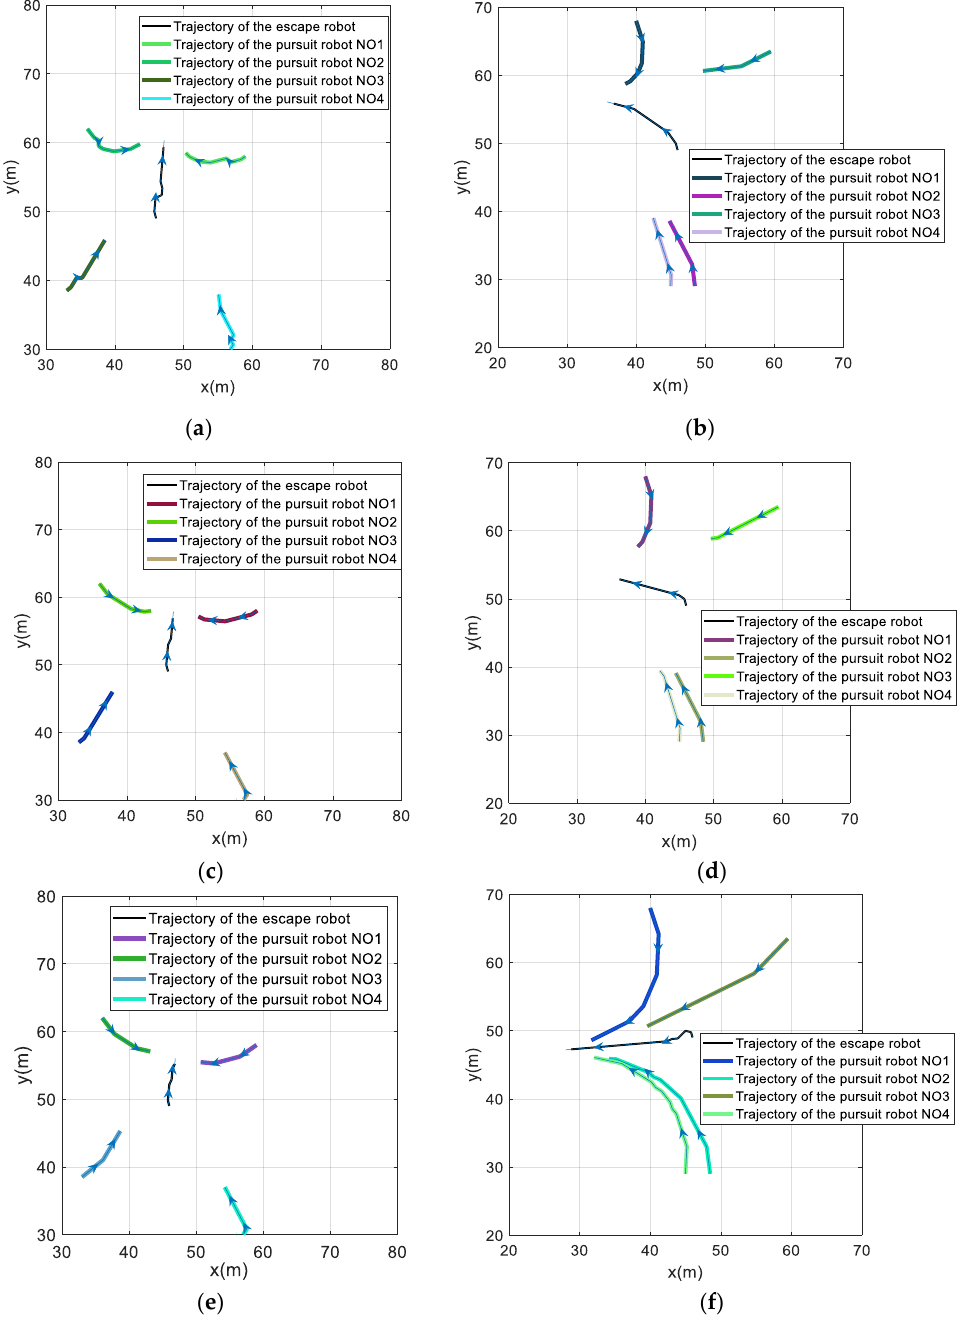
Figure 10. Pursuit results corresponding to the different initial positions and different speeds of pursuit robots: ( a ) V p e